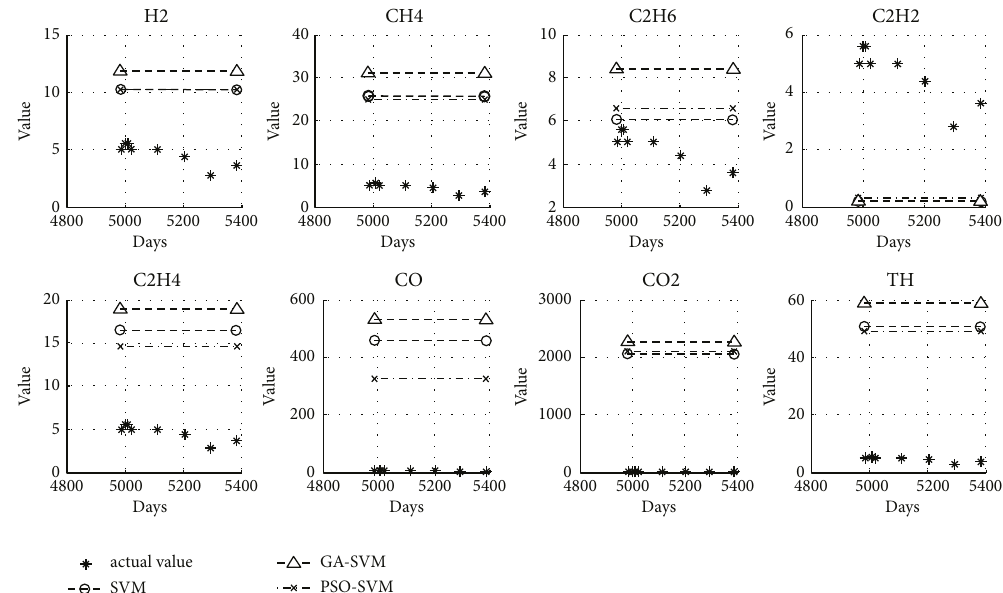
Figure 10: The monitored gas concentration values during the 13 th refueling cycle compared to the values predicted by different